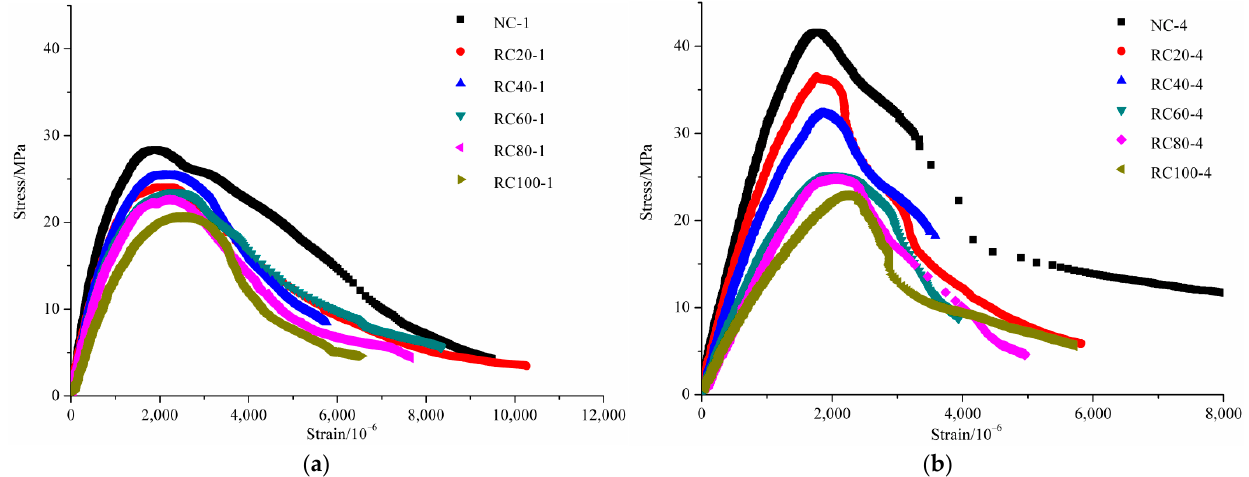
Figure 11. Stress–strain curves for RAC with the same carbonation depth: ( a ) uncarbonated concrete, ( b ) fully carbonated concrete.